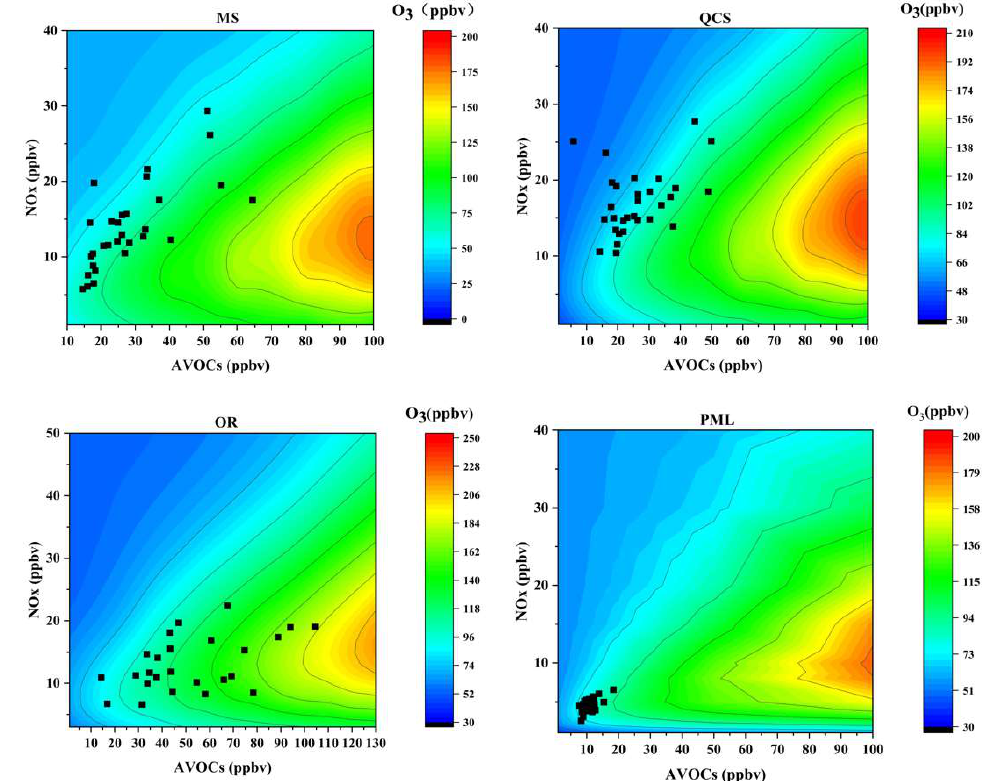
Figure 8. Empirical kinetics modeling approach curves for each site during the observation period. (The black dots represent the location of the daily average volume fraction of the VOCs and NO x during the observation period).